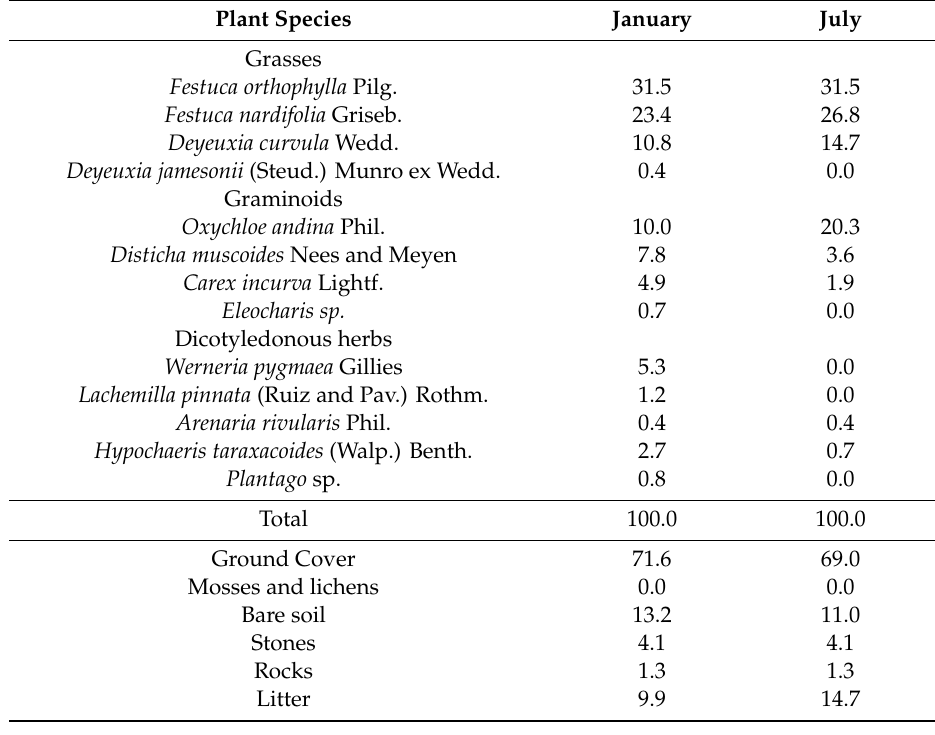
Table 1. Botanical composition of the grasslands where the study was carried out, in two contrasting periods: January (rainy–summer) and July (dry–winter) in Caquena, Putre County (18 ◦ 03’ S, 69 ◦ 13’